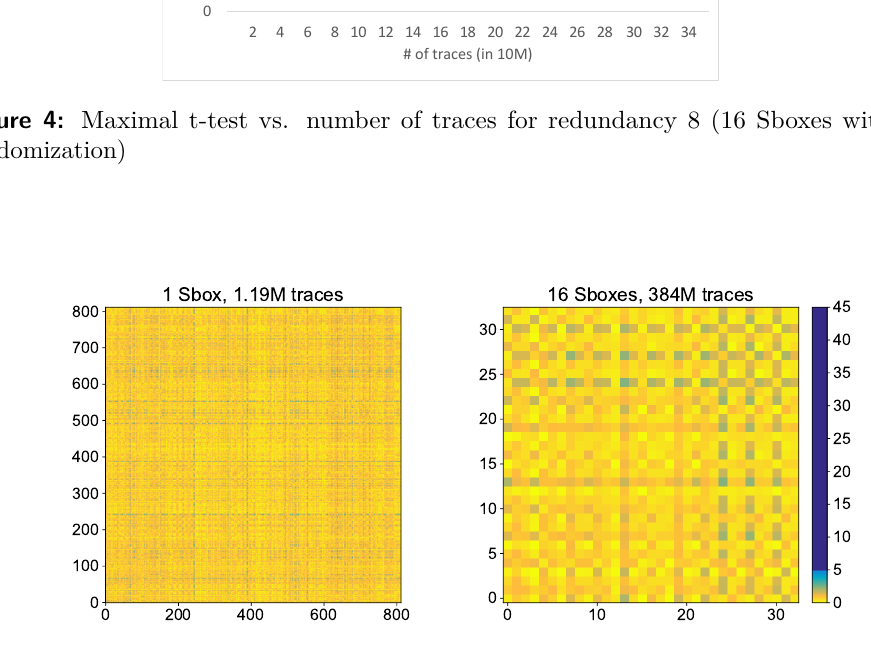
Figure 5: Bivariate second order TVLA results (redundancy 8 with re-randomization)